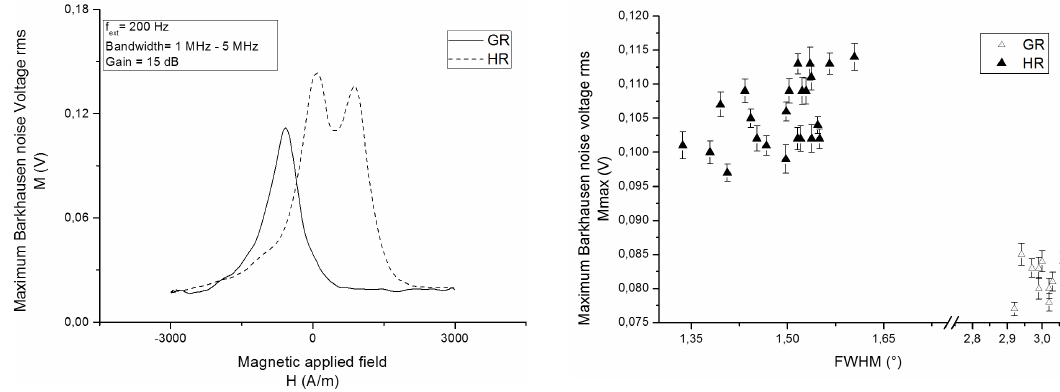
Figure 4. RMS envelope of Barkhausen noise for samples in HR and GR conditions.